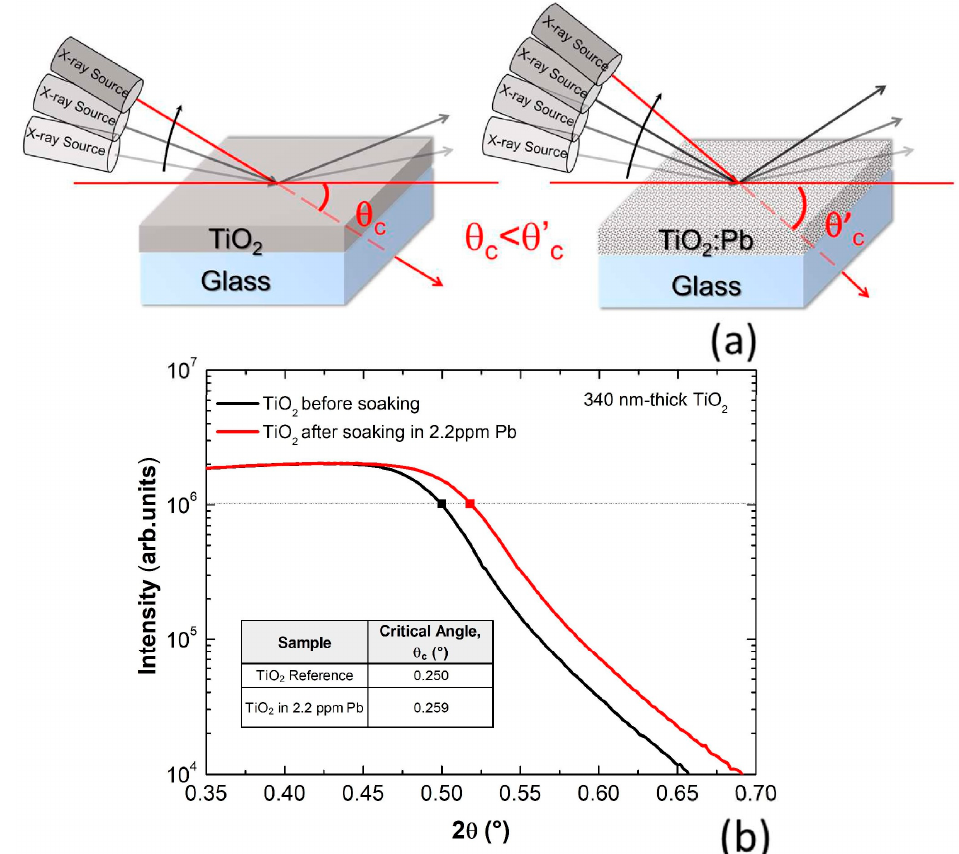
Figure 1. ( a ) Schematics of the working principle for X-ray reflectivity analyses on a gig-lox TiO 2 sample deposited on a glass substrate. The presence of lead in the gig-lox films causes an increase of the critical angle θ c . ( b ) X-ray reflectivity curves from TiO 2 films (340 nm-thick) before and after soaking into an aqueous solution containing 2.2 ppm of Pb. The black line represents the TiO 2 sample before soaking and the red line represents the same sample after soaking, with its critical angle shifted rightwards.